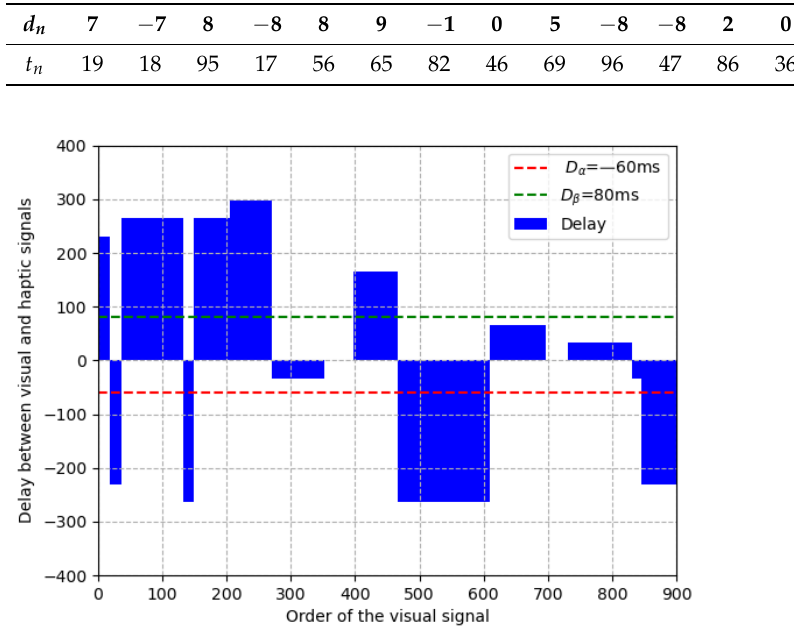
Table 3. An example of random delay in the experiment.